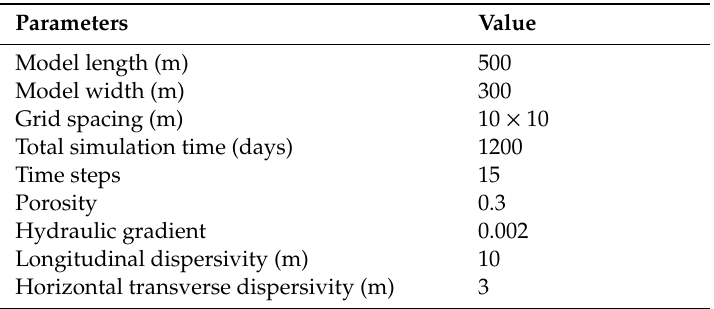
Table 5. Basic parameters of the reactive transport model in Case 3.